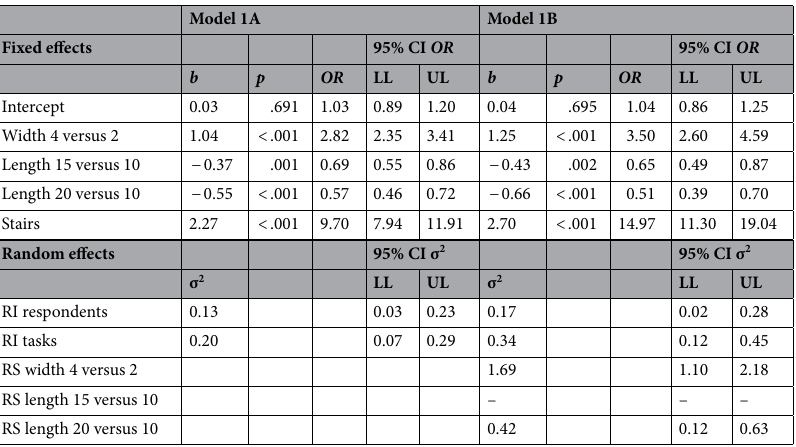
Table 3. Results of logistic models with separated corridor parameters. RI, random intercept; RS, random